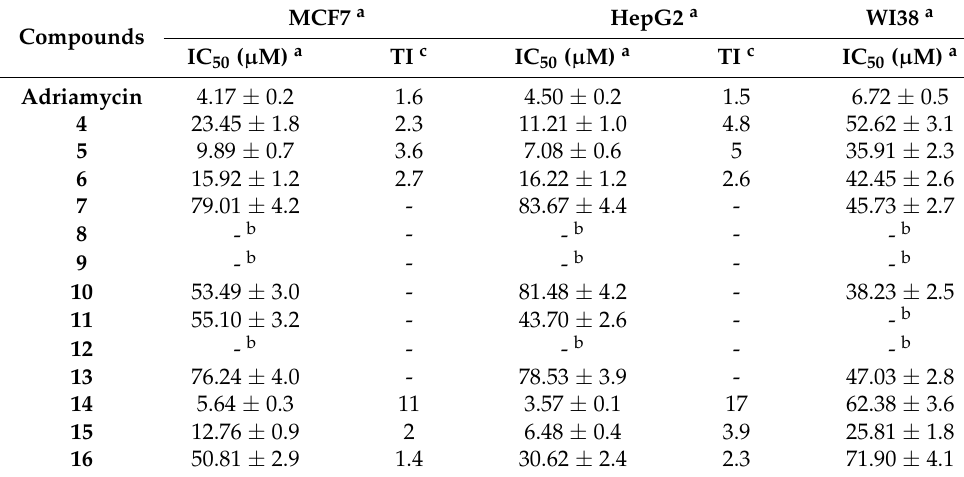
Table 1. The antiproliferative activities of the OSe compounds.